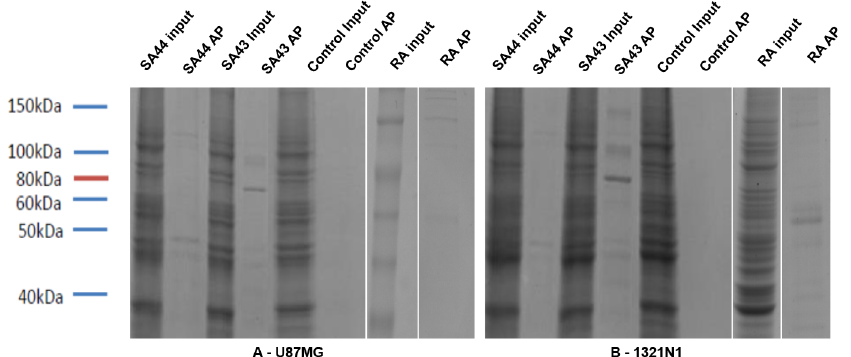
Fig 7. Aptamer precipitation using SA43 and SA44 resulted in the purification of a number of proteins from U87MG and 1321N1. Aptamer precipitation (AP) with either SA43 or SA44 was performed with streptavidin agarose beads with protein extracts prepared from either U87MG (A) or 1321N1 (B). Whole-cell extracts (input) and aptamer precipitated proteins were visualised using comassie blue stain. The control AP contained no aptamer and random aptamer (RA).